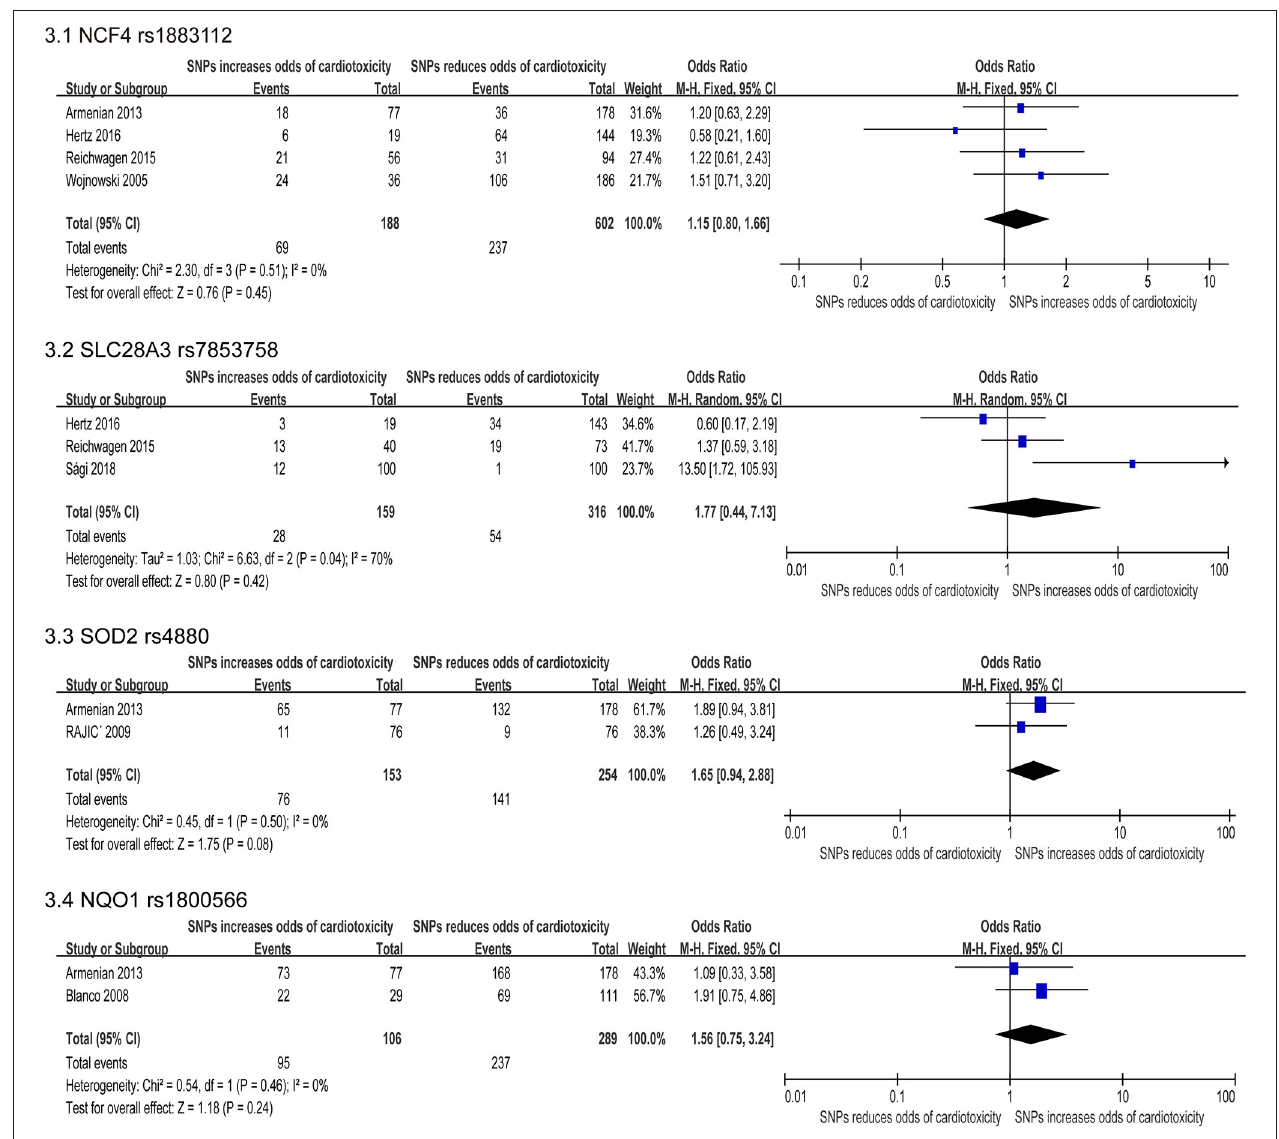
FIGURE 3 | Forest plot of meta-analysis for 4 SNPs. Four variants, NCF4 rs1883112, SLC28A3 rs7853758, SOD2 rs4880, and NQO1 rs1800566, are not statistically significant for chemotherapy induced cardiotoxicity.